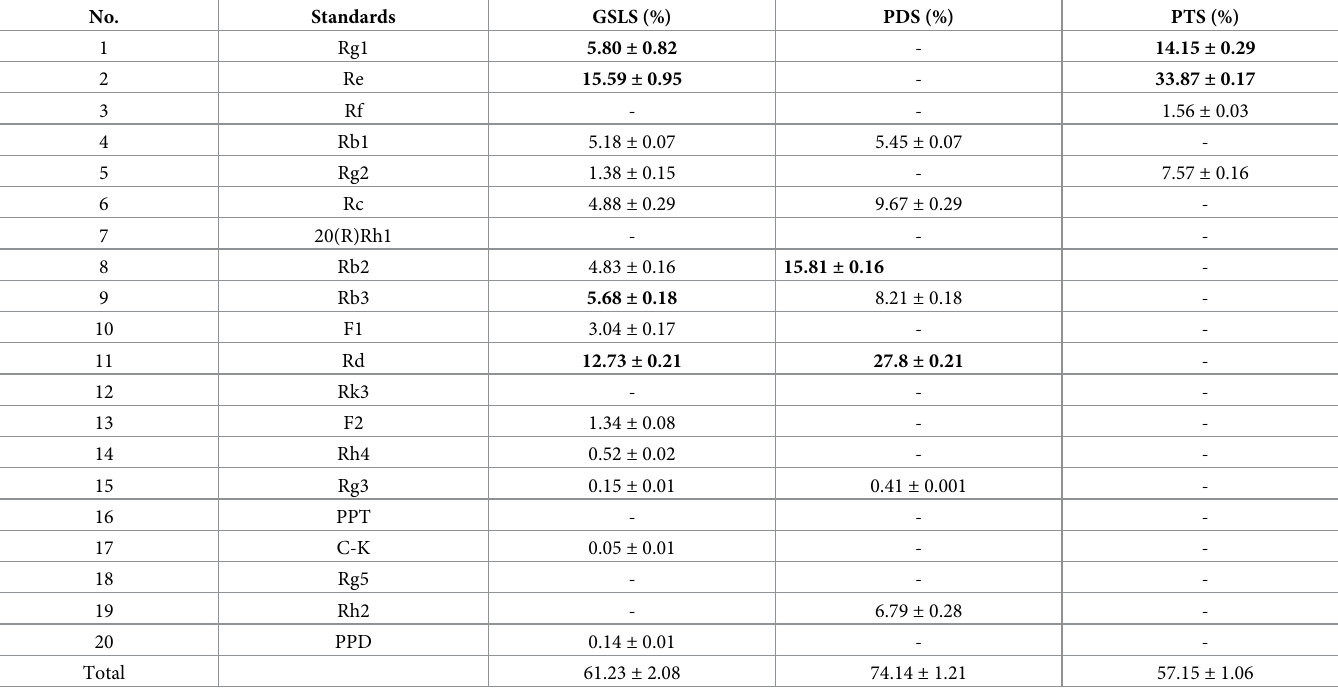
Table 1. Composition content of total ginsenoside from the stem and leaves of Panax ginseng , and PDS and PTS.